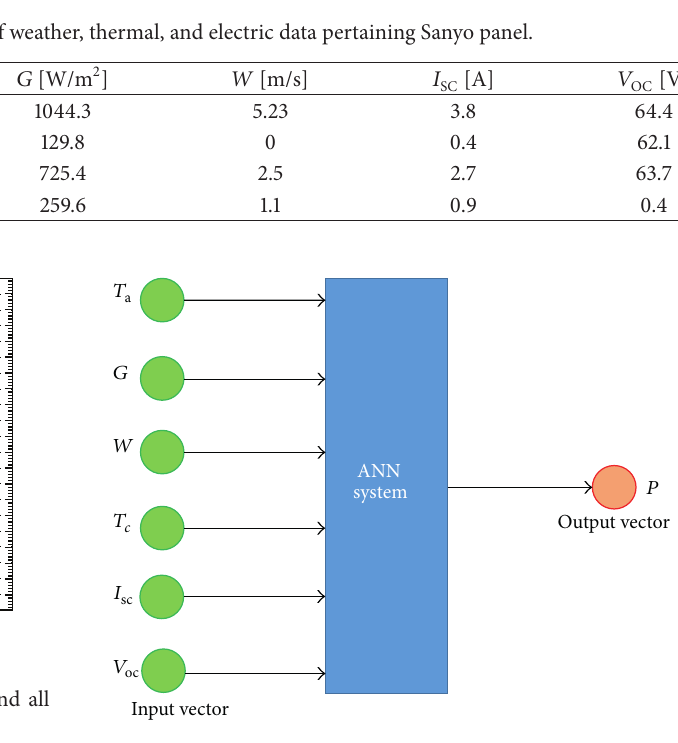
Figure 8: Definition of input and output vectors of the tested